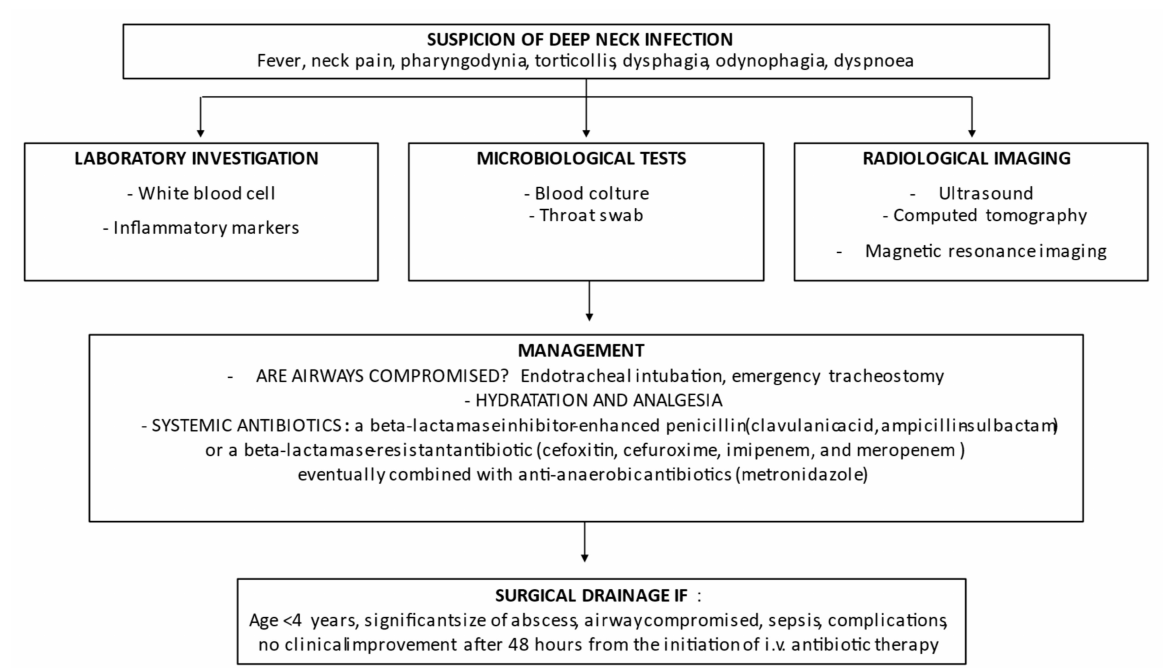
Figure 3. Flow-chart on management of deep neck infections in pediatric